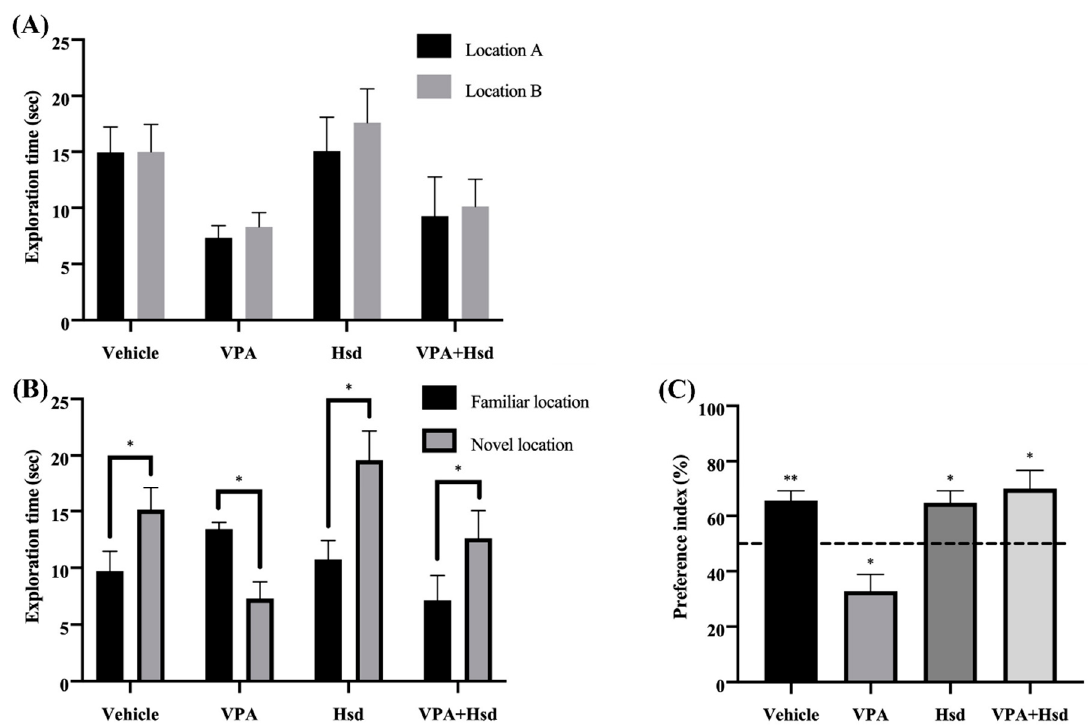
Figure 2. Hesperidin (Hsd) co-administration alleviated the valproic acid (VPA)-caused memory impairment shown in the novel object location (NOL) test. The exploration times (mean ± SEM) of the rats of exploring the objects in the familiarization locations during the familiarization trial ( A ). There was no significant difference in the time exploring the objects placed in locations A and B among the groups ( p > 0.05). In the choice trial ( B ), the rats from the VPA group explored the objects in the familiar locations more than the novel locations (* p < 0.05). In contrast, the rats in the vehicle, Hsd, and VPA+Hsd groups significantly explored the object in the novel location more than the familiar location. The PI revealed a significant variation from 50% chance in the vehicle (** p < 0.01, ( C ), Hsd, and VPA+Hsd groups (* p < 0.05), whereas the rats in the VPA group displayed significantly lower than 50% chance (* p < 0.05).